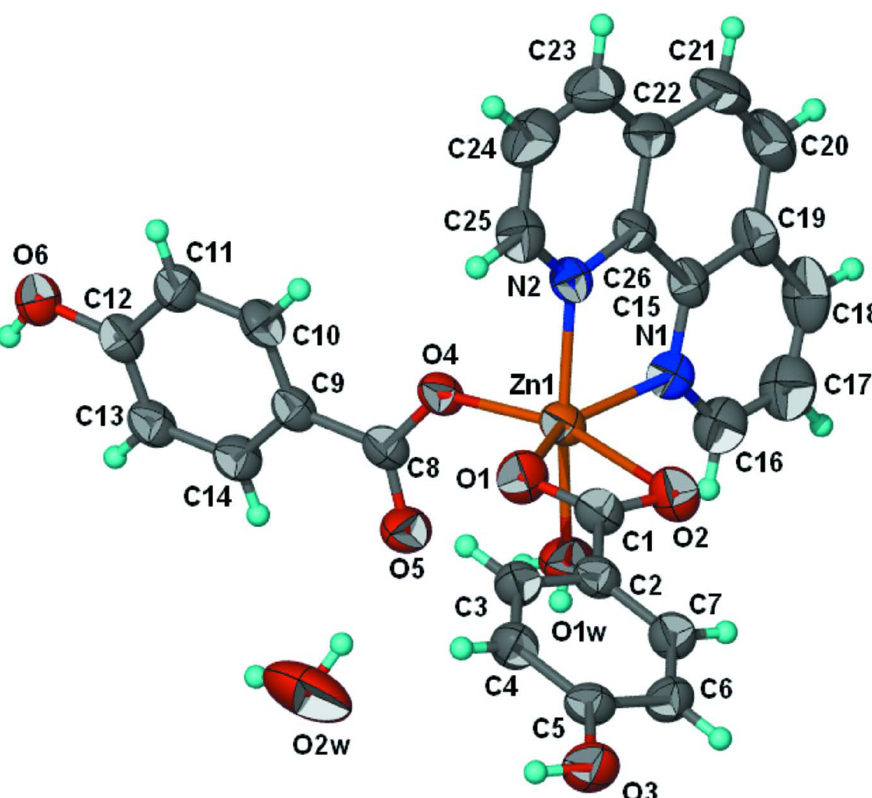
Figure 1 View of the molecular structure of (I) with displacement ellipsoids drawn at the 50% probability level (H atoms drawn as spheres of arbitrary